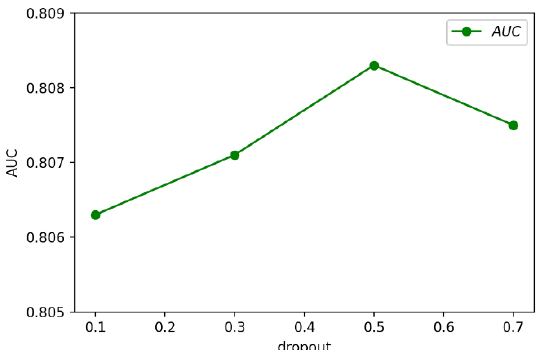
Figure 4. The impact of dropout on the model.